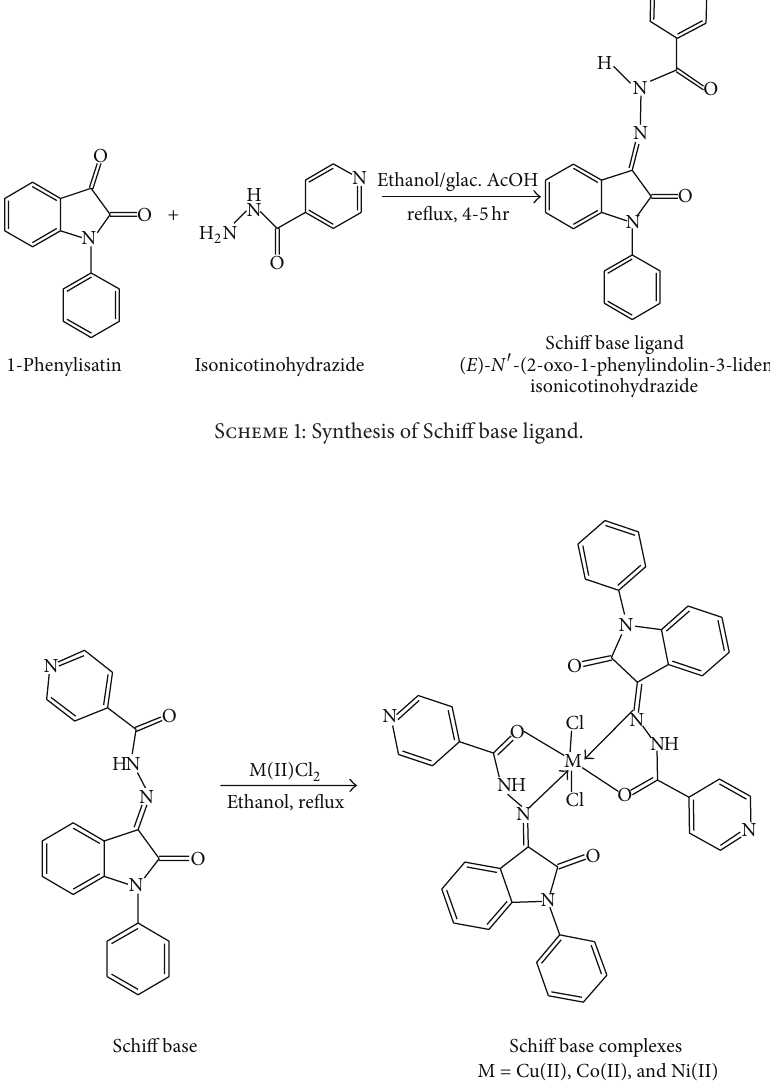
Scheme 2: Synthesis of Schiff base